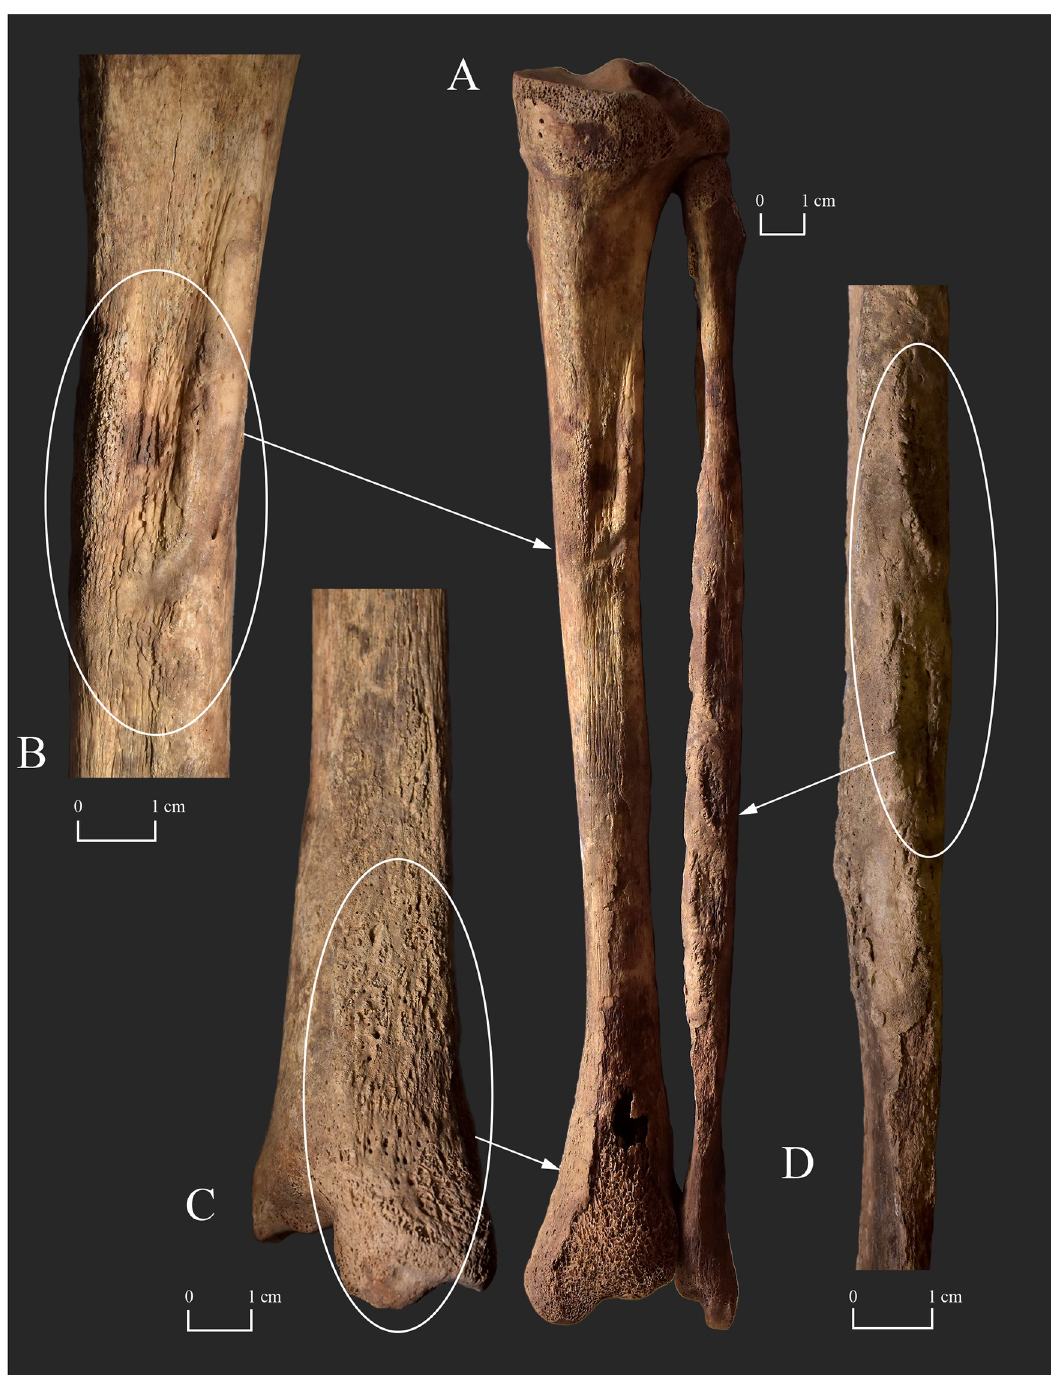
Fig 11. Surface pitting and subperiosteal new bone formations on the right tibia and fibula (white ellipses) of KD520. A) Dorsal view of the right tibia and fibula, and close-up of the B) shaft of the right tibia (posterior surface), C) distal part of the right tibia (medial surface), and D) shaft of the right fibula (posterior